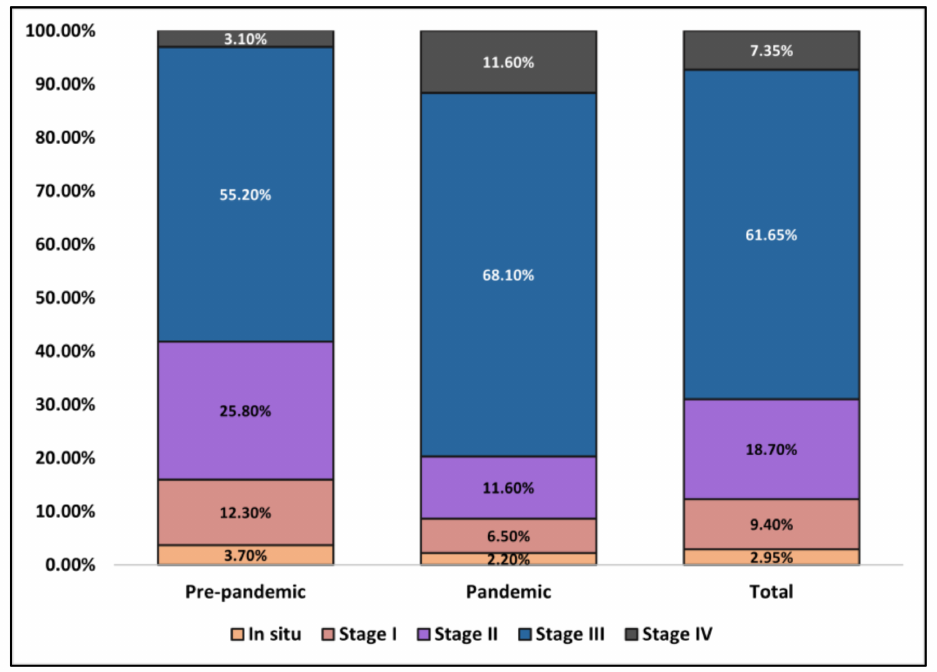
Figure 3. Comparison in AJCC malignant melanoma staging between patients seeking medical care before and during the COVID-19